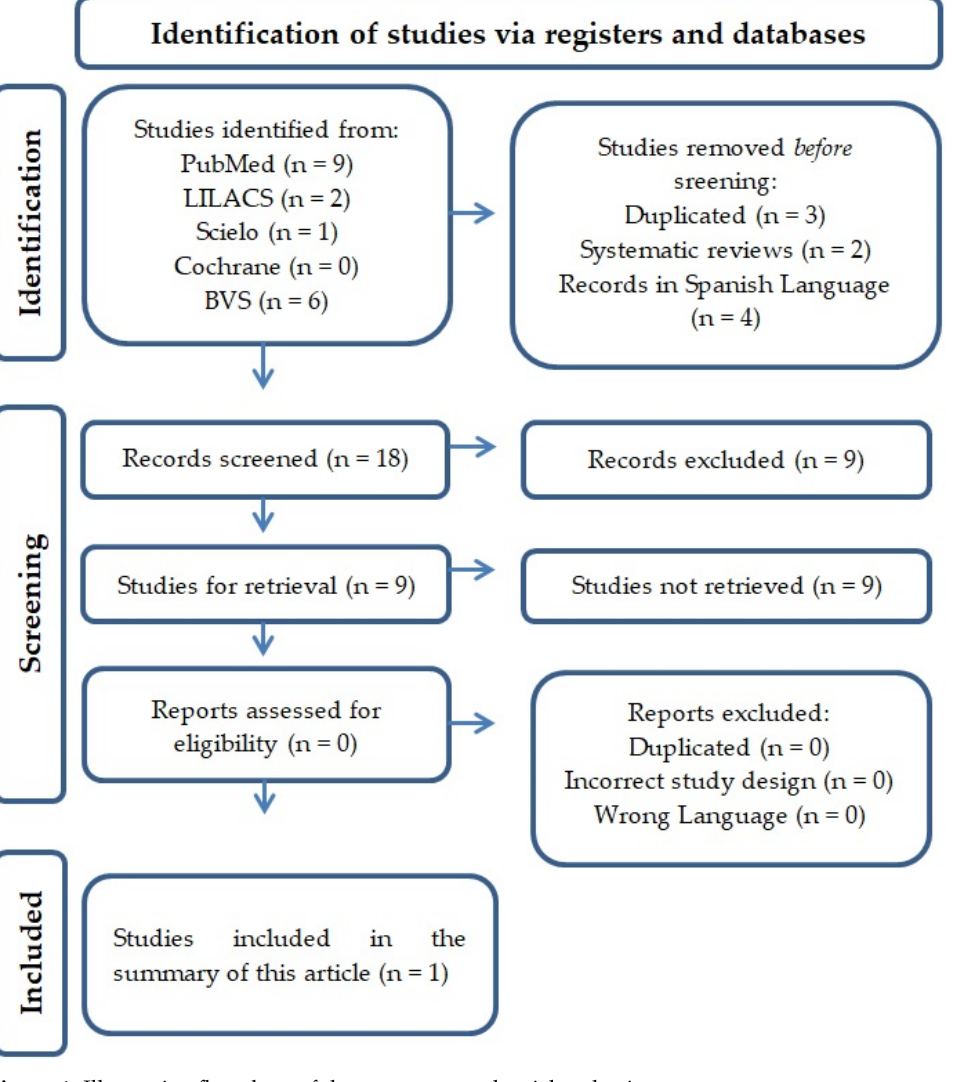
Figure 1. Illustrative flowchart of the rummage and article selection.